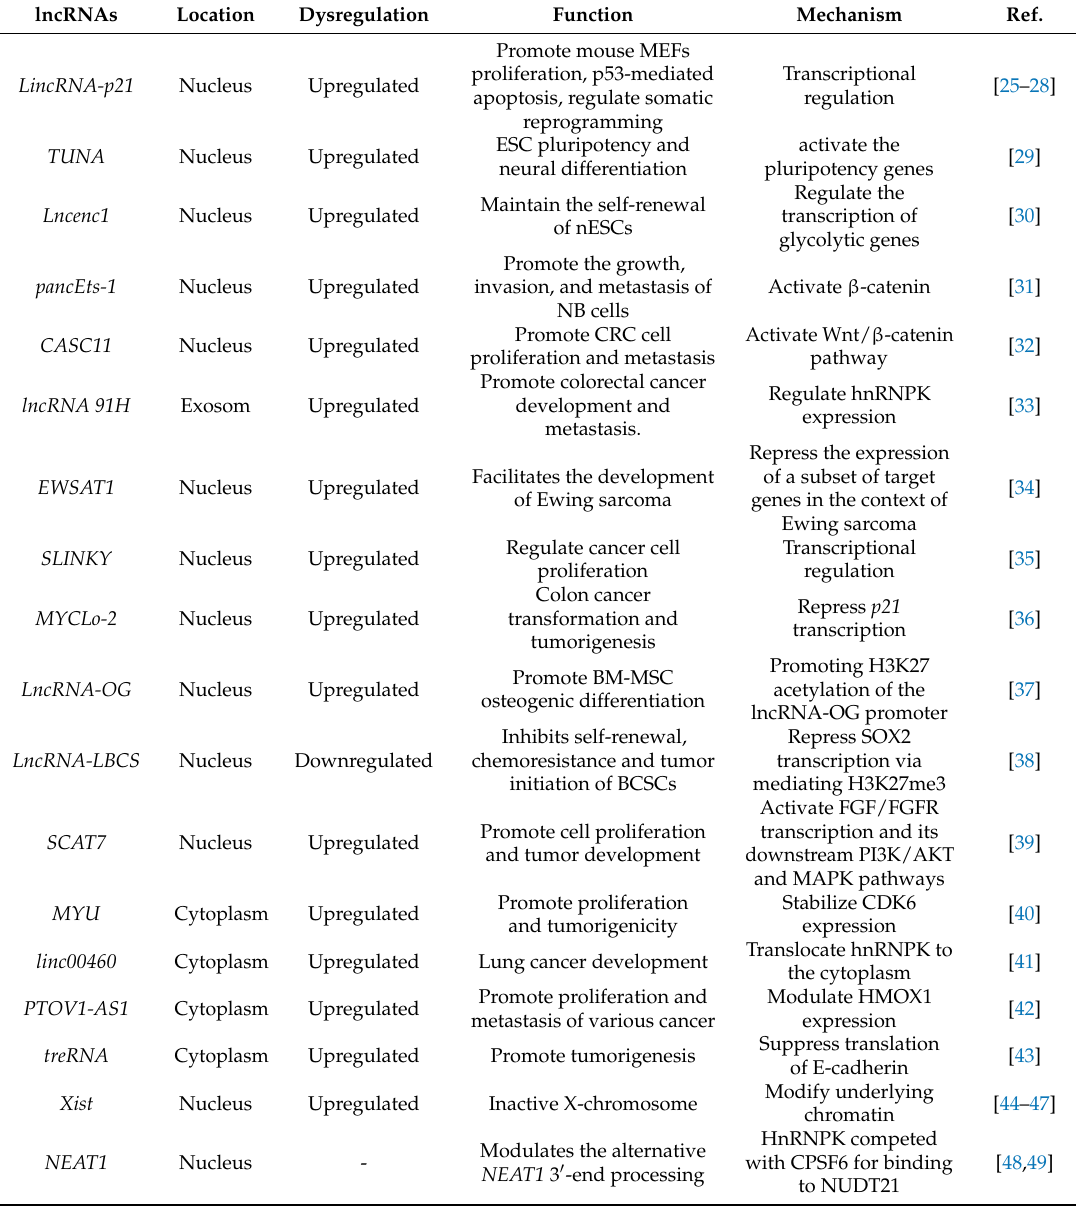
Table 1. Molecular function of heterogeneous nuclear ribonucleoprotein K (hnRNPK) and long non-coding RNAs (lncRNAs)